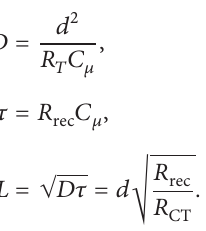
Fully illuminated module One shaded cell Two shaded cells Figure 8: I-V characteristics experimental data for different shading ratesillustratedassymbolsandoneshadedcell,twoshadedcells,and fully illuminated module.